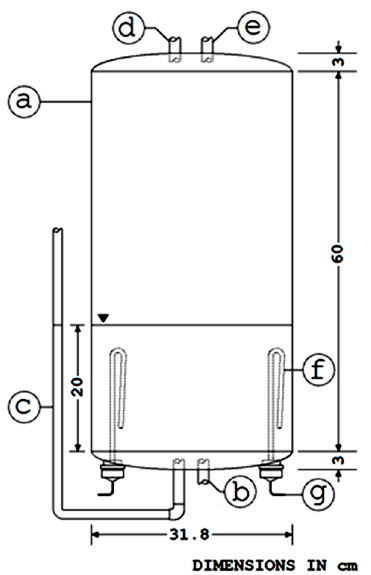
Figure 3. Configuration of a local-made water heating vessel. (a) Water heating vessel, (b) water inlet, (c) transparent hose, (d) forced air inlet, (e) air and water vapor mixture outlet, (f) electric heating element, (g) electric wires.